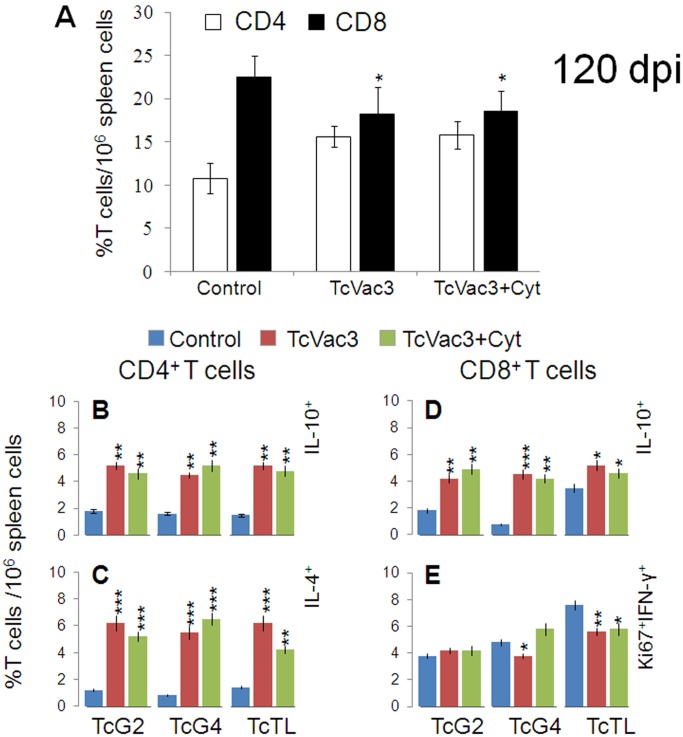
Functional profile of vaccine-induced T cells during chronic chagasic disease.Mice were vaccinated and infected as in Fig. 5, and harvested at day 120 post-infection. (A) Splenic frequency of CD4+ and CD8+ T cells. (B &C) Splenocytes were stimulated as in Fig. 5. (B&E) Shown are percentages of CD4+T cells that were IL-10+ (B) and IL-4+ (C); and the percentages of CD8+T cells that were IL-10+ (D) or Ki67+IFN-γ+ (E), measured by flow cytometry.